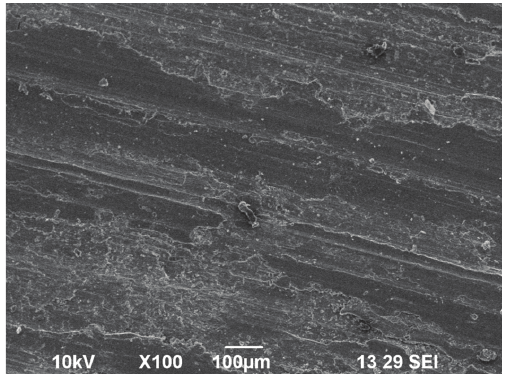
Figure 4: Worn surface of red mud reinforced aluminium matrix at optimal setting.